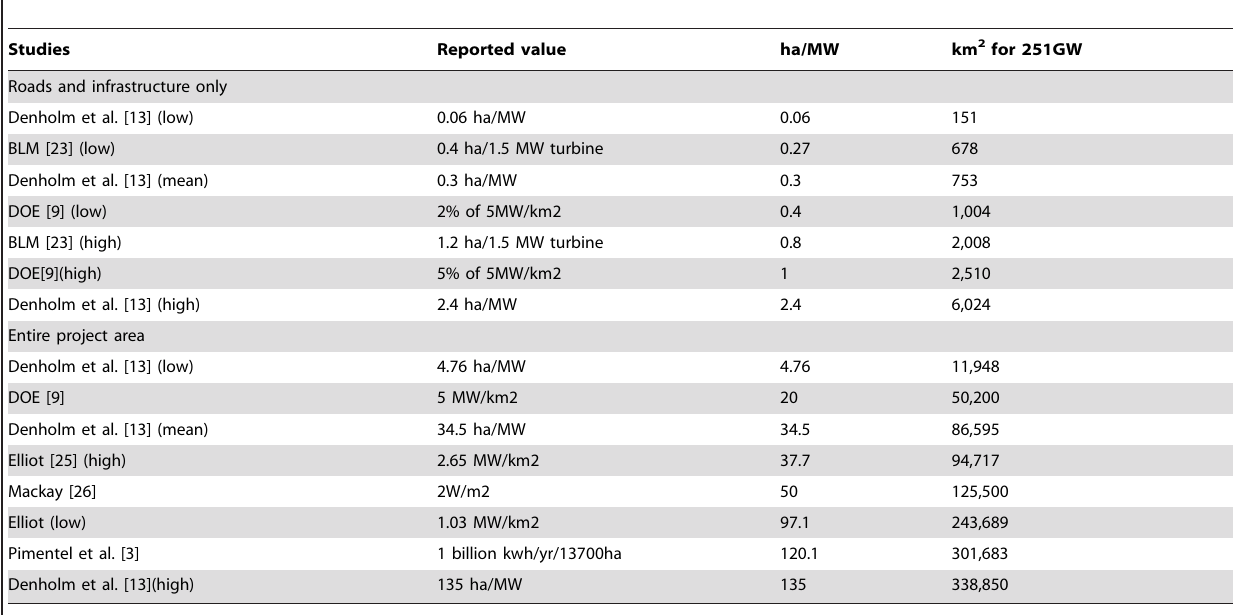
Table 1. Reported values of land transformation associated with wind development, the original value transformed into ha/MW, and the predicted amount of land transformation required to meet 251GW of land based wind energy—a stated goal of the Depart- ment of Energy (DOE)